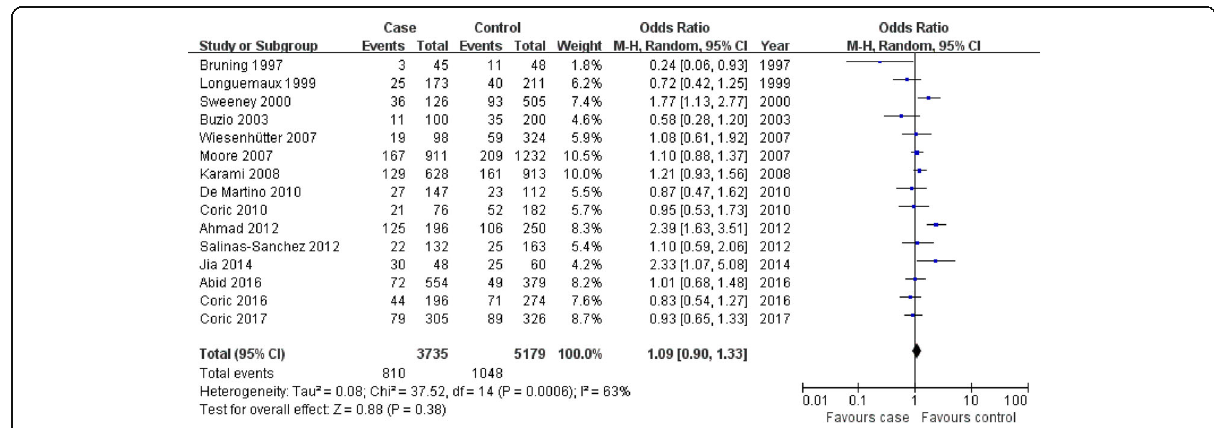
Fig. 3 Association between the GSTT1-null genotype and RCC susceptibility in the overall population. CI: confidence